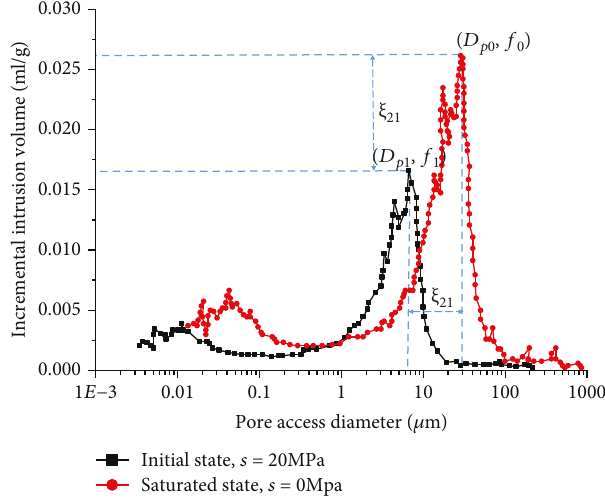
Figure 3: MIP results of bimodal soil [51].